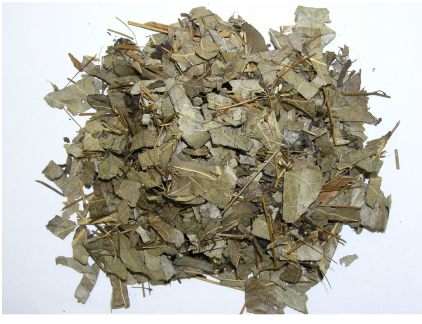
Figure 1. Photo of Herba Epimedii.